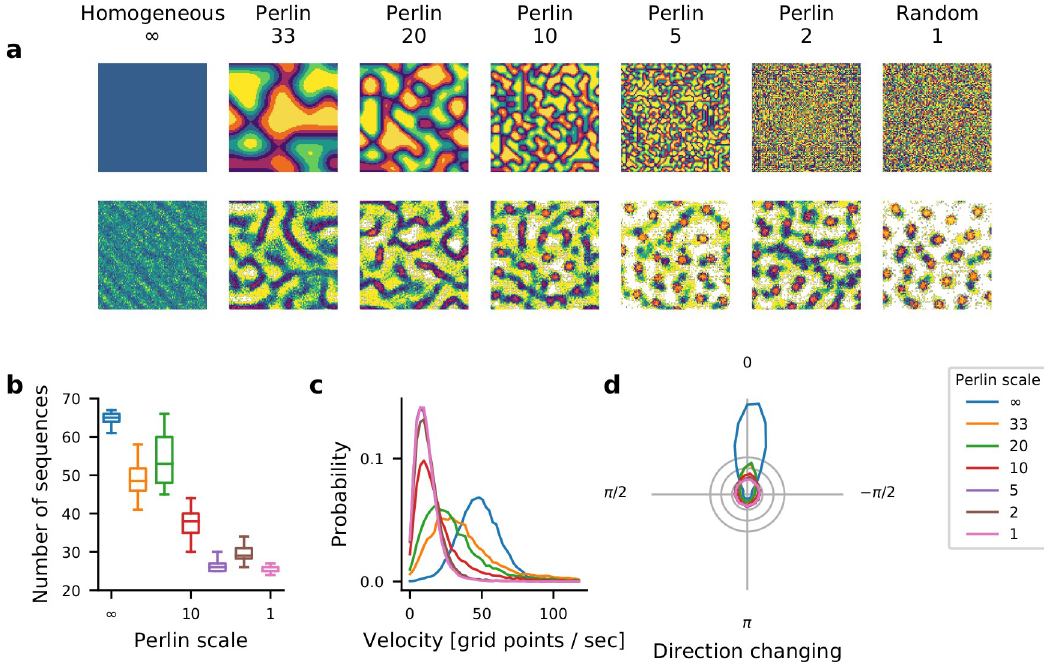
Fig 6. Effect of spatial scale of correlations in ϕ on the emergence and velocity of STAS in I-networks. (a) The top row shows the spatial distribution of ϕ for different scales of Perlin noise. The Perlin scales decreased from left to right as reflected in the size of single color blobs. The Perlin scale is indicated in terms of grid points in the network. The bottom row shows the spatial distribution of average firing rates in each of the seven configurations. (b) The number of STAS observed in 1 sec. for different Perlin scales. The box plot shows that statistics of STAS estimated over 90 epochs of 1 sec. each. Different colors indicate the scale of the corresponding Perlin noise. (c) The distribution of the velocity of STAS. Different colors indicate the scale of the corresponding Perlin noise. (d) The distribution of STAS directions in polar plots. In a homogeneous configuration, most sequences moved in a single direction (blue curve). As the Perlin scale decreased, the distribution of movement direction became more widely distributed, indicating an increase in the number of sequences that moved in different